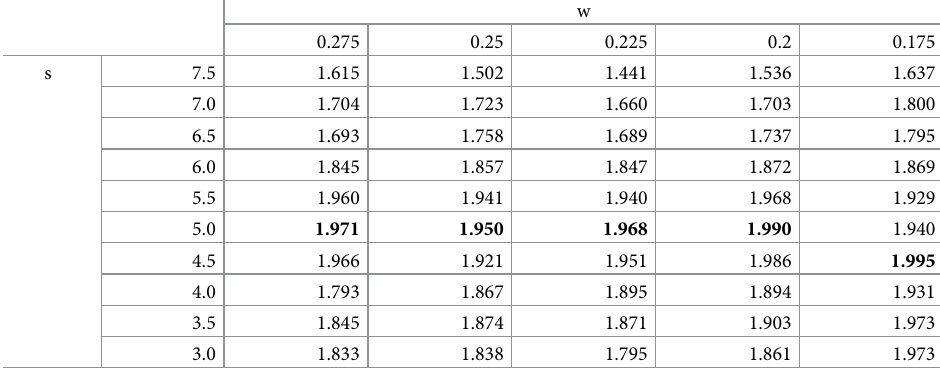
Table 1. The results of calculating the index values from images created by a range of paired w and s values, peak- ing at s = 4.5–5.